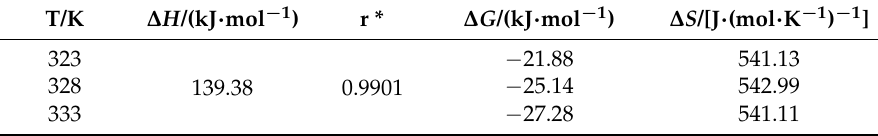
Table 3. Thermodynamic parameters of the lysozyme–tannic acid system at 323, 328, and 333